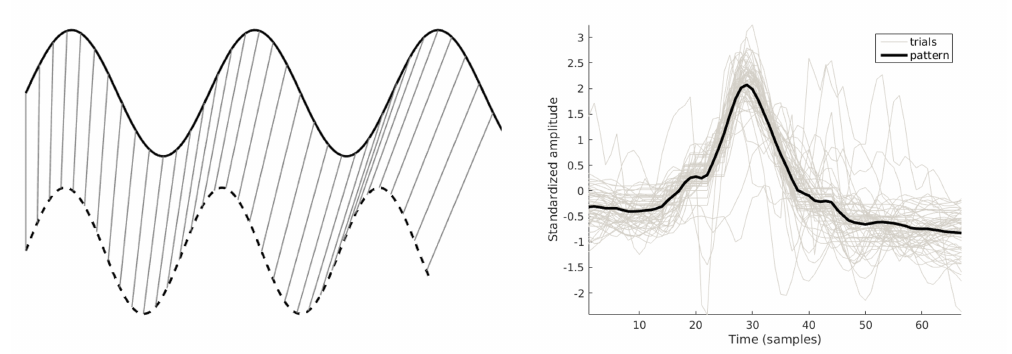
Figure 4. A simple example of dynamic time warping ( Left ) and its application to derive a sit-to-stand pattern ( Right , only one channel is